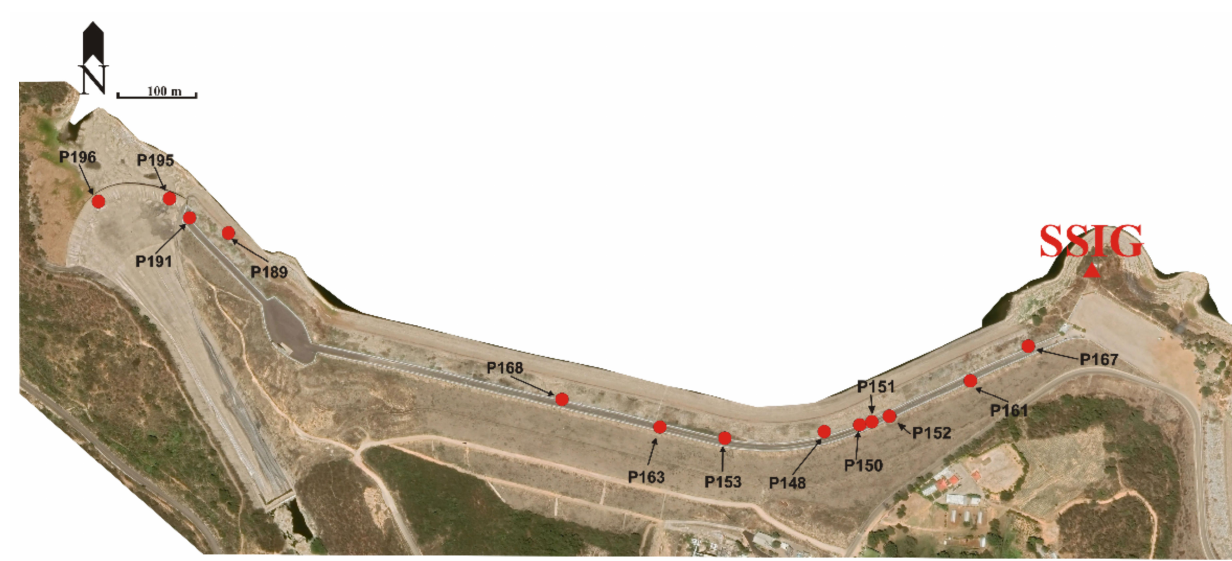
Figure 7. Location of the 13 PSs identified along the Sanalona dam in the MT-InSAR analysis.